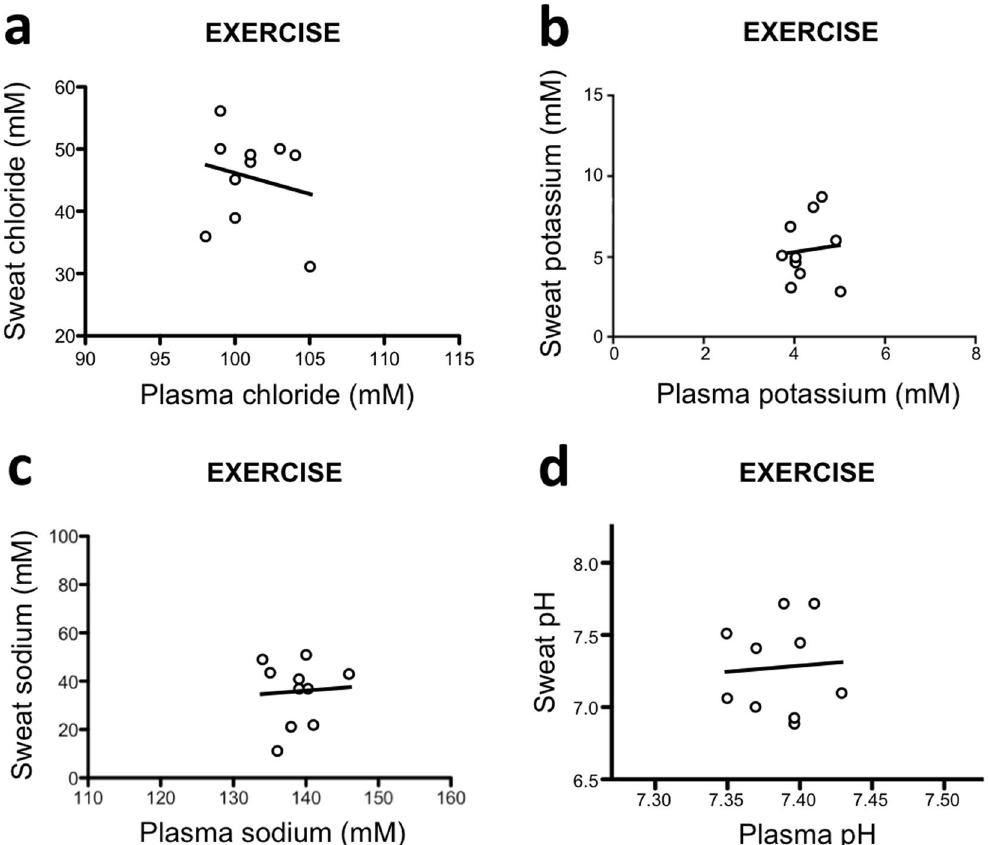
Figure 1. Relationship between electrolyte levels or pH in blood and sweat produced following physical exercise. Healthy subjects performed cycling exercise (120 W; 20 min). Blood samples (3 mL) were obtained via venous puncture. Sweat samples (90 microL) were collected in the lower back using a FinnPipette TM . Levels of chloride ( a ), potassium ( b ) and sodium ( c ) as well as pH ( d ) were measured using a Cobas TM 8000